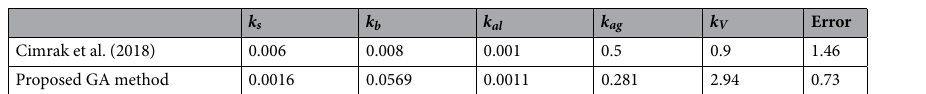
Table 6. Parameter values for healthy RBC identified using the stretch experimental data of Mills et al. 3